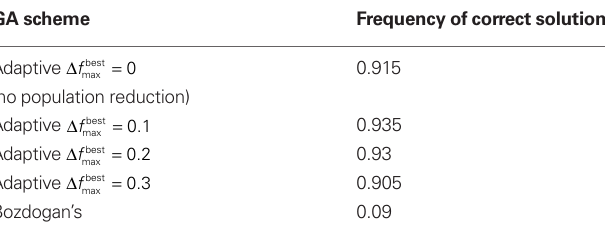
Table 2 | Parameters that were the same for all genetic algorithm schemes.